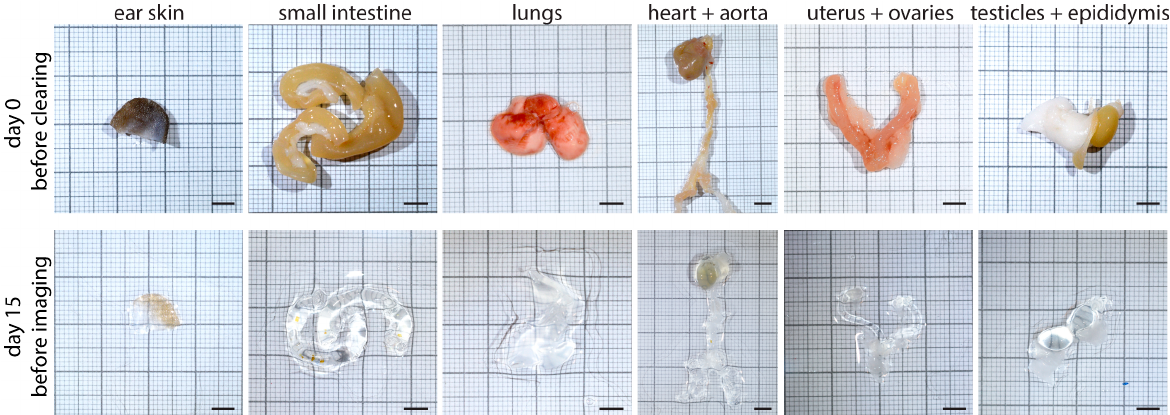
Figure 3. Tissue samples before and after the tissue-clearing protocol. Various organs of adult C57BL/6 or Prox1 GFP mice are shown on day 0 before the start of our protocol and on day 15 before imaging. Scale bar 5 mm (n = 5 organs of 5 mice). Representative images of the experiments are shown.